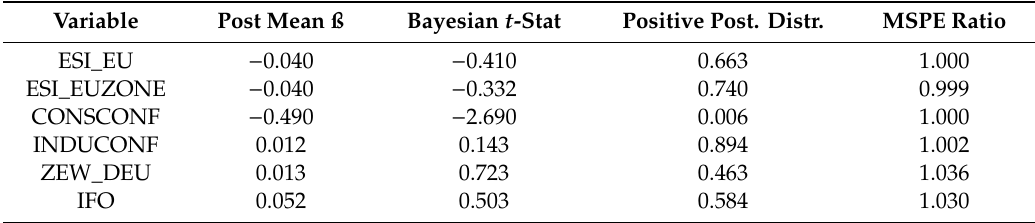
Table 2. Set of regressions on the EU